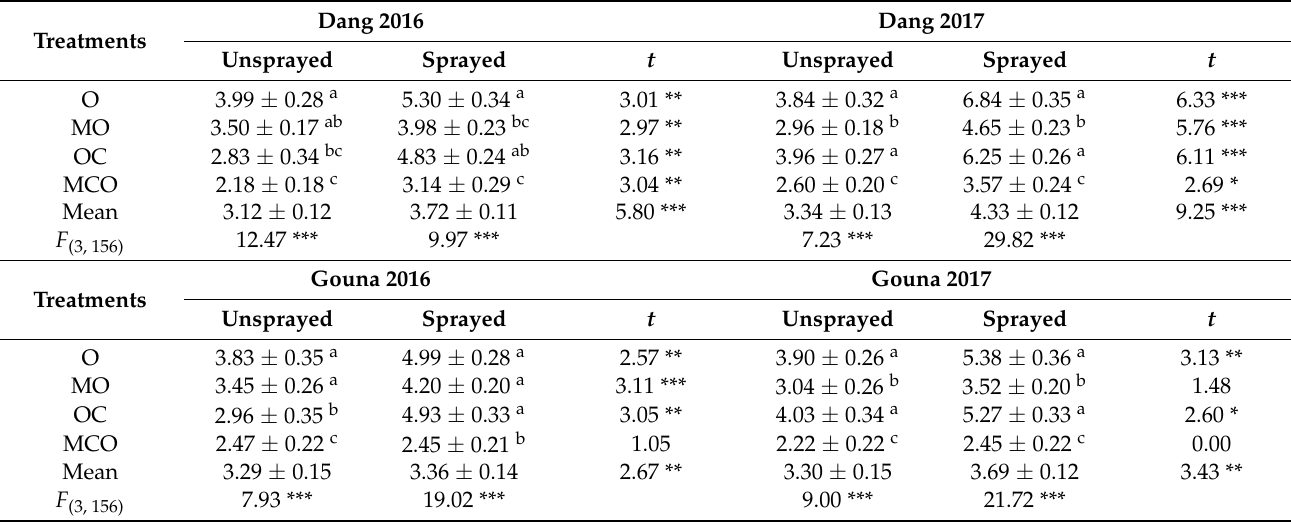
Table 5. Okra fruit yield (t ha − 1 ) as influenced by Cypermethrin treatments and intercropping system in 2016 and 2017 at Dang and